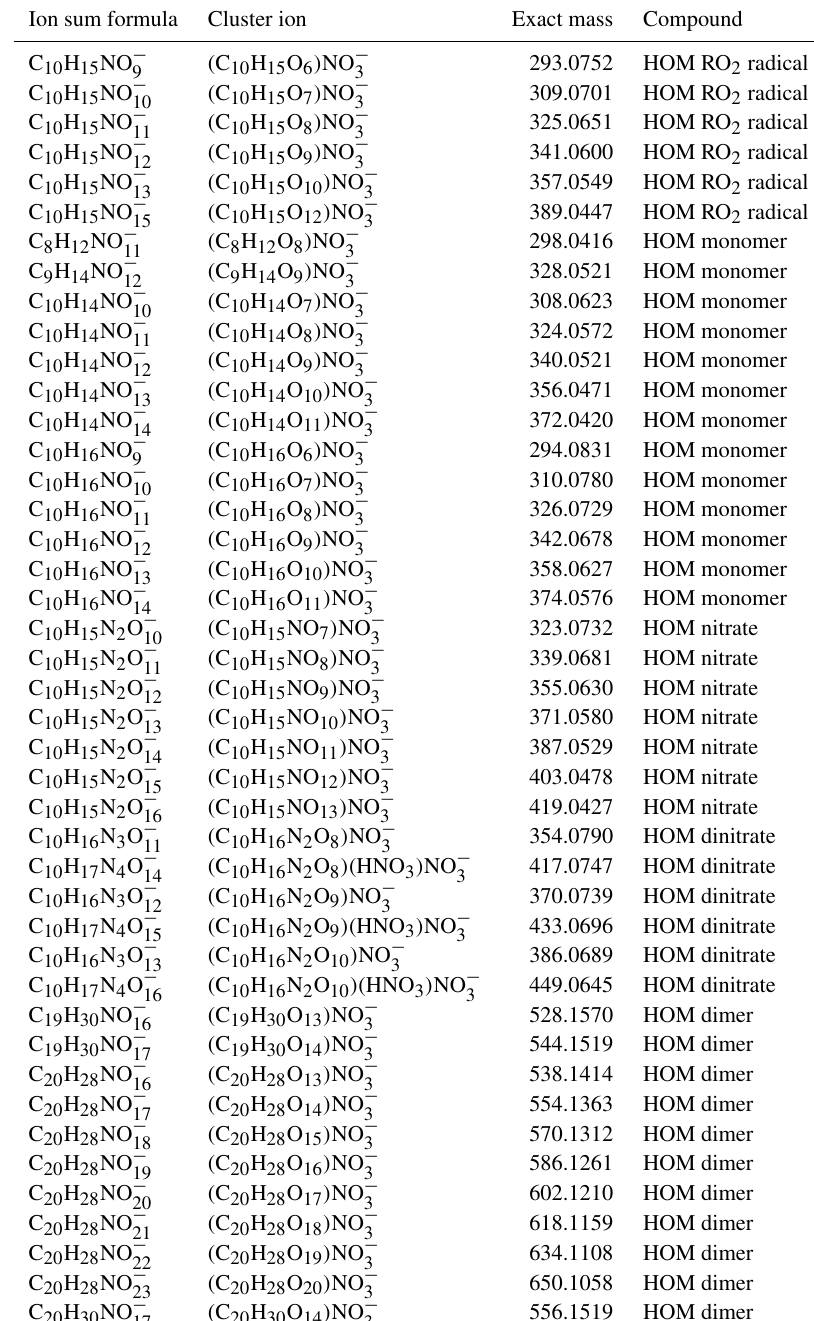
Table 2. Peak list of the highly oxidized organic molecules (HOMs) used in this study. Ion sum formula Cluster ion Exact